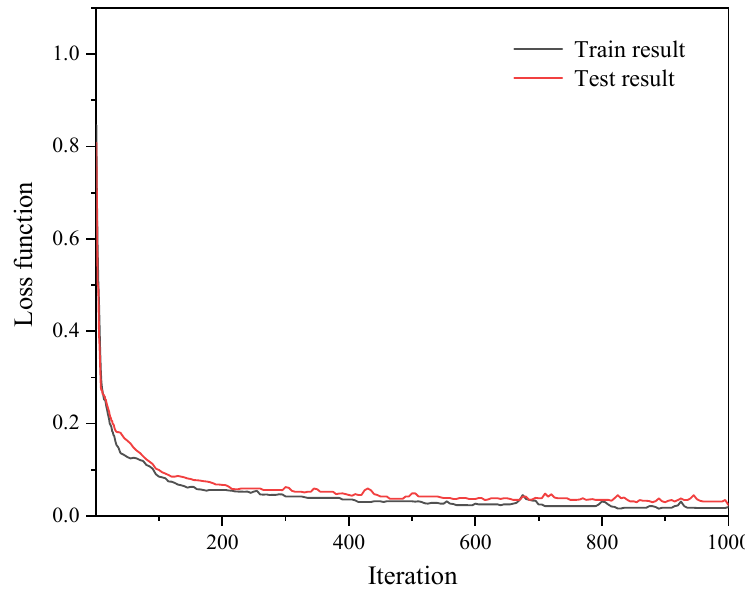
Figure 7. Loss function of the optimized series feedback neural network.